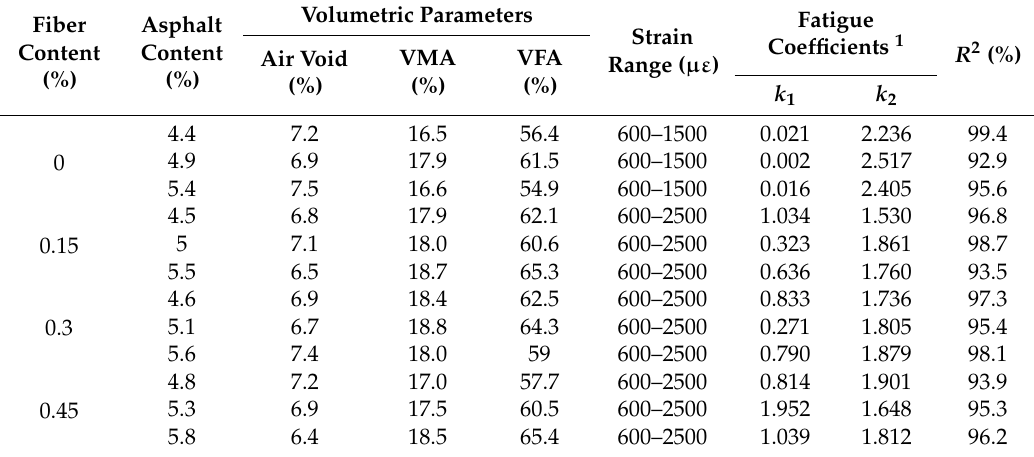
Table 5. Test results of volumetric parameters and fatigue